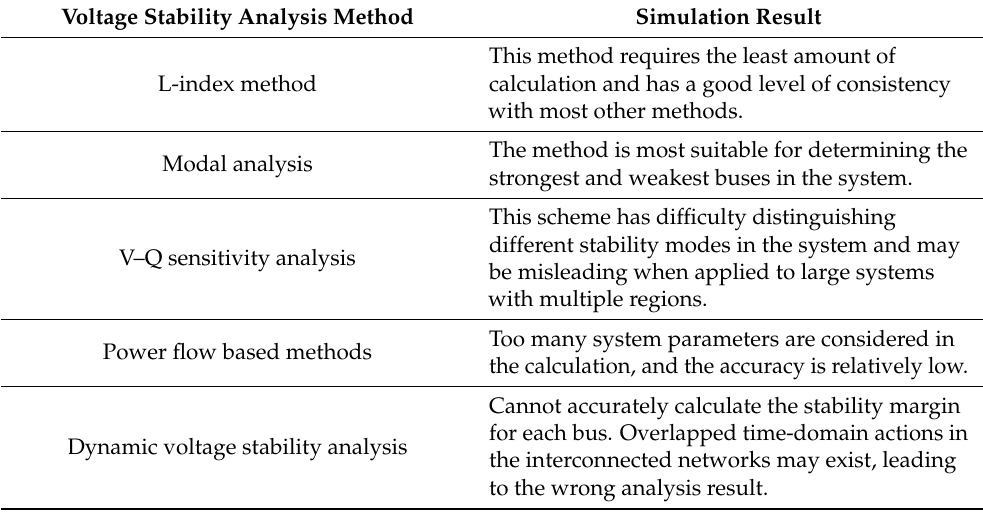
Table 4. Summary of the various voltage stability analysis